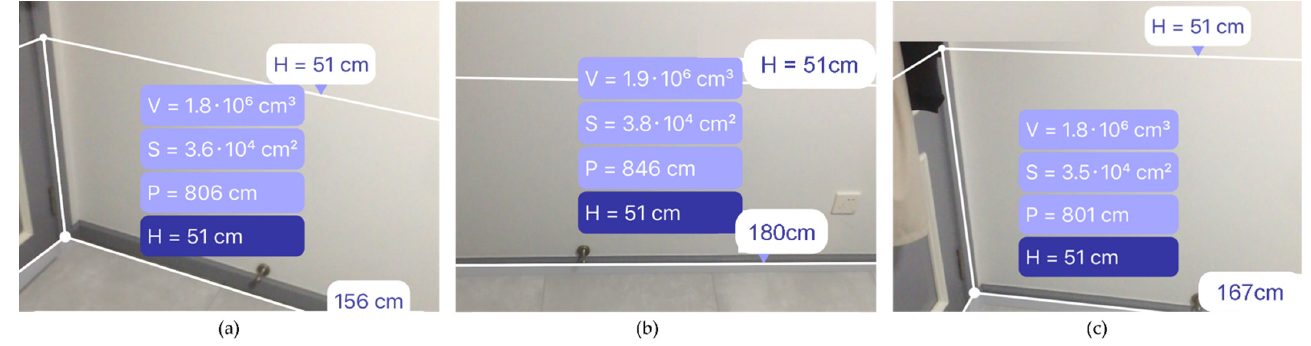
Figure 6. Real-time capture results of virtual marker information from different perspectives: ( a ) the capture results from a top-down perspective; ( b ) the capture results from a square perspective; ( c ) the capture results from an upward view.